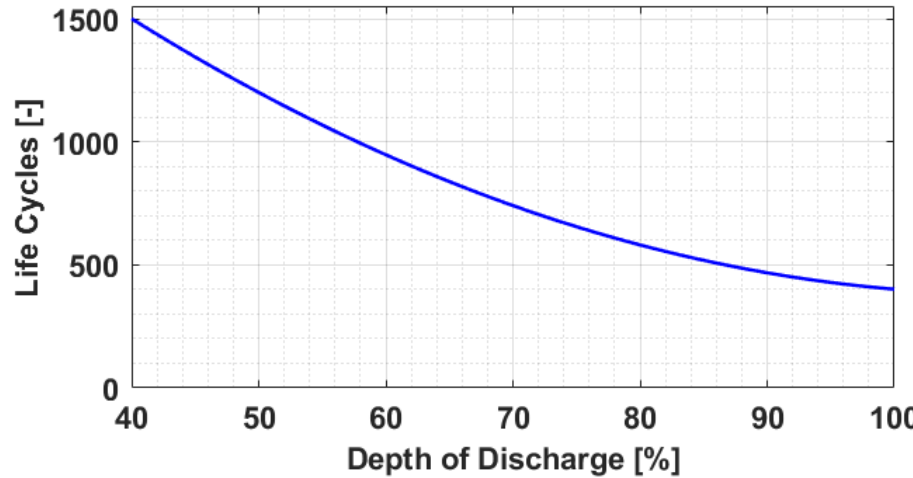
Figure 8. Trend of the battery life cycles as a function of the depth of discharge.